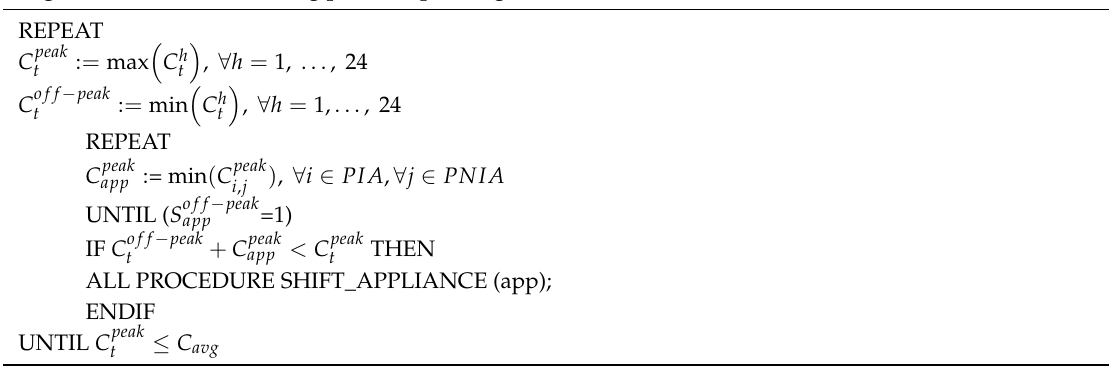
Algorithm 1 Gradual-shifting peak/off-peak algorithm